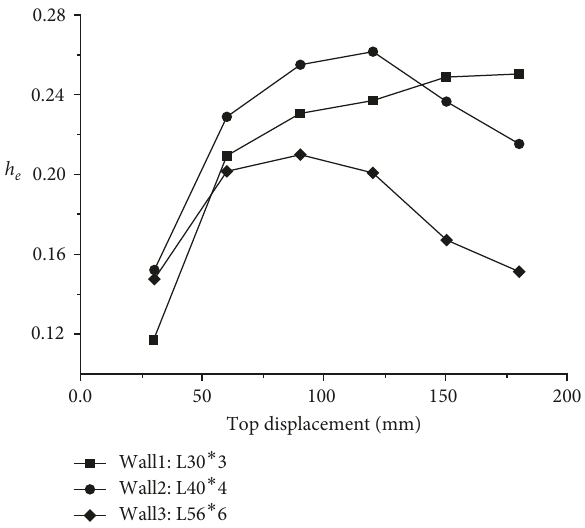
Figure 16: Equivalent viscous damping coefficient, h